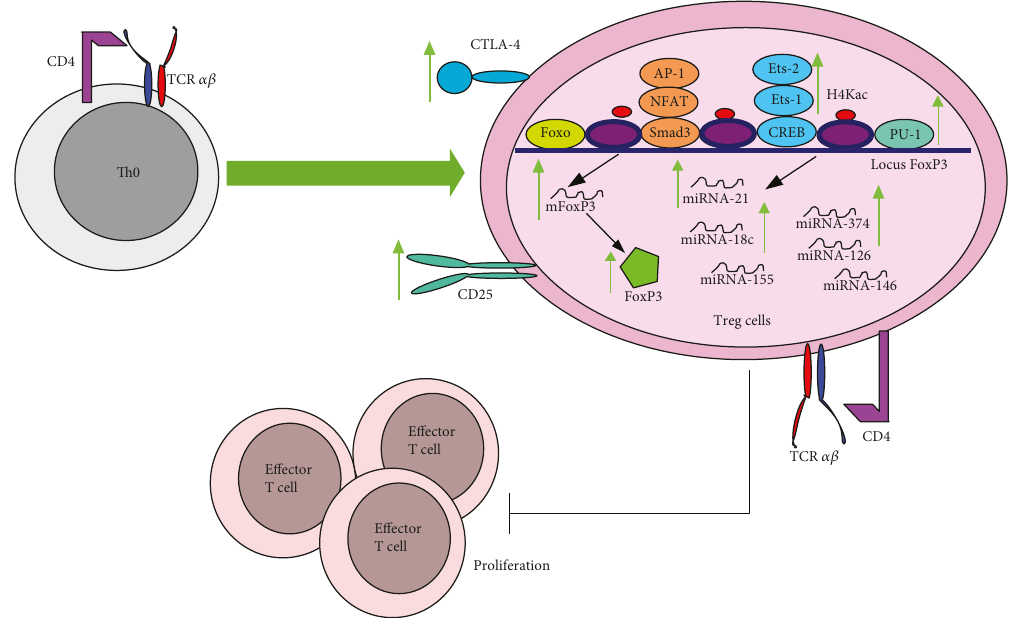
Figure 12: VPA promotes the generation of Treg cells. Naïve T lymphocytes that are treated with VPA di ff erentiate into Treg cells due to epigenetic modi fi cations (H4 histone acetylation) that allow the entry of the transcription factors Ets-1, Ets-2, and PU.1 into the promotor region of Foxp3, which induces its transcription and translation. VPA also increases the expression of miRNA-21, miRNA-18c, and miRNA-327, as well as of CD25, which are characteristic of Treg lymphocytes. However, it also induces the exhaustion molecule CTLA-4. Interestingly, VPA-induced Treg cells can block the proliferation of PBMC and T e ff ector lymphocytes. Green arrows indicate the processes, molecules, or mediators in the signaling pathway that are augmented and/or promoted by VPA. Red arrows indicate processes, molecules, or mediators in the signaling pathway that are inhibited by